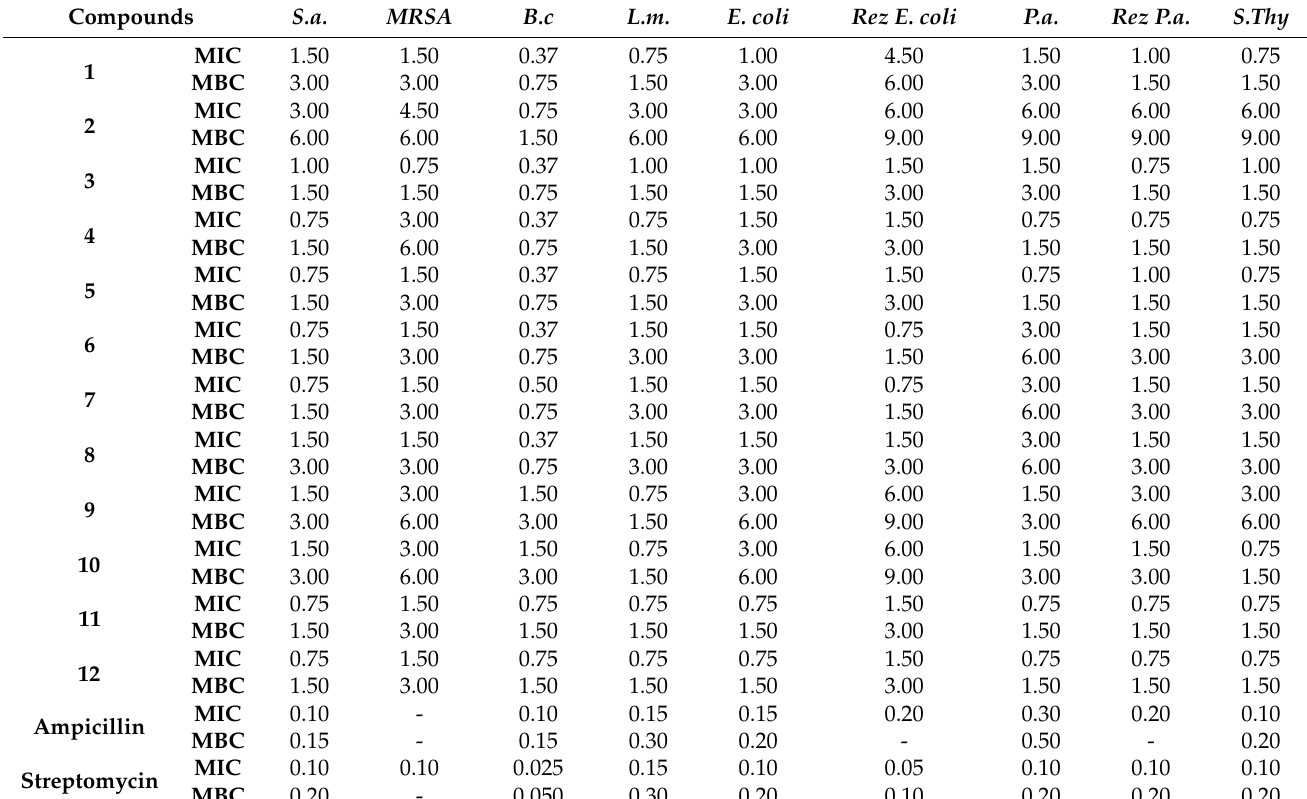
Table 1. Antibacterial activity of compounds 1 – 12 (MIC/MBC in